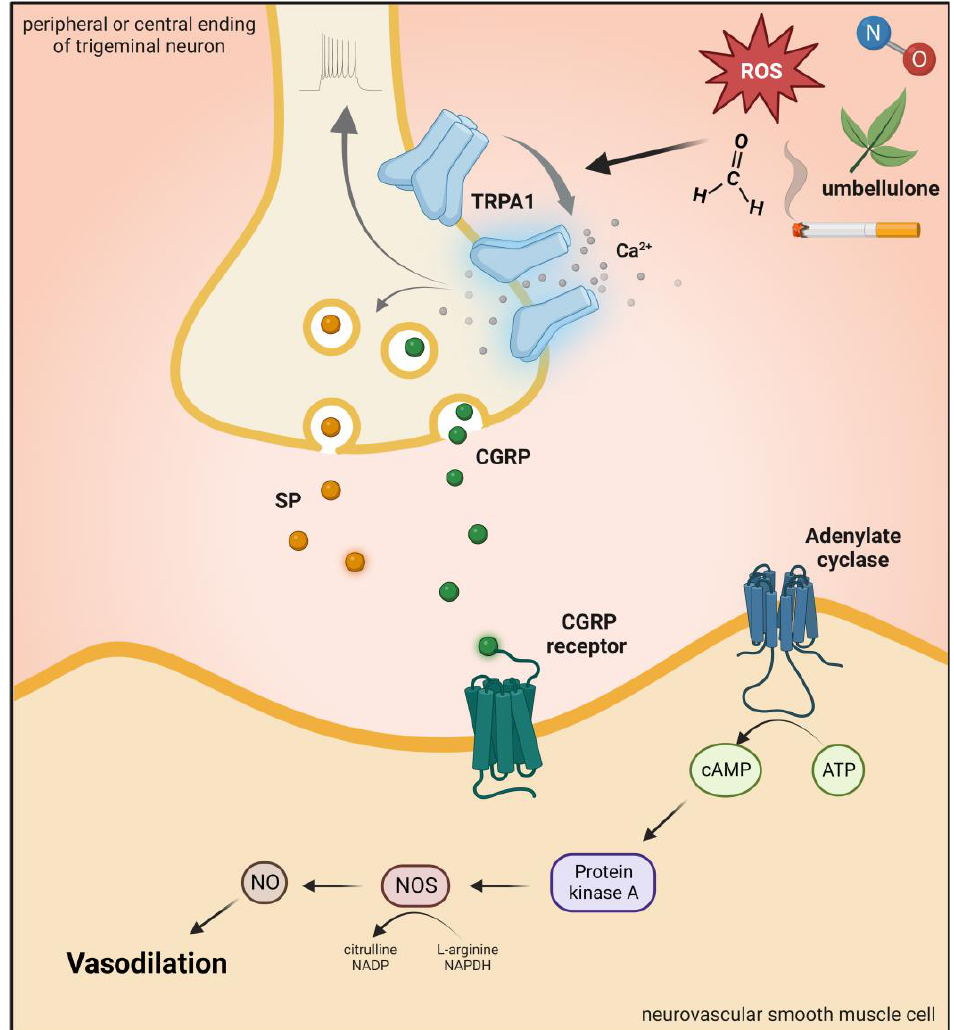
Figure 6. Transient receptor potential ankyrin 1 receptor activation. Activation of TRPA1 in sensory neurons induces an increase in Ca 2+ and leads to the release of the neuropeptide CGRP, SP, and NOS-derived NO, thus mediating vasodilation. TRPA1: transient receptor potential ankyrin 1 re- ceptor, CGRP: calcitonin gene-related peptide, SP: substance P, ROS: reactive oxygen species.